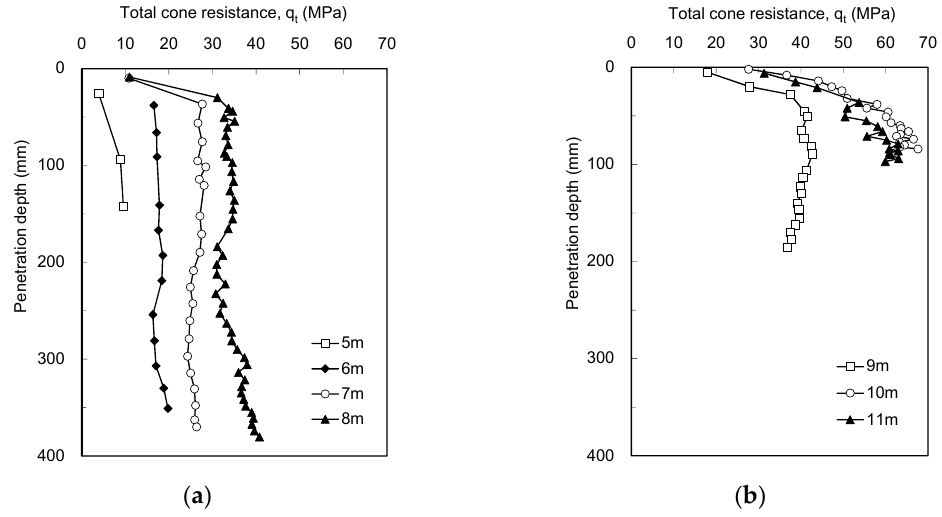
Figure 14. Profiles of the total cone resistance obtained at each depth at site B: ( a ) 5–8 m; ( b ) 9–11 m. Note that the data points at all depths indicate the penetration depths at every three blows.